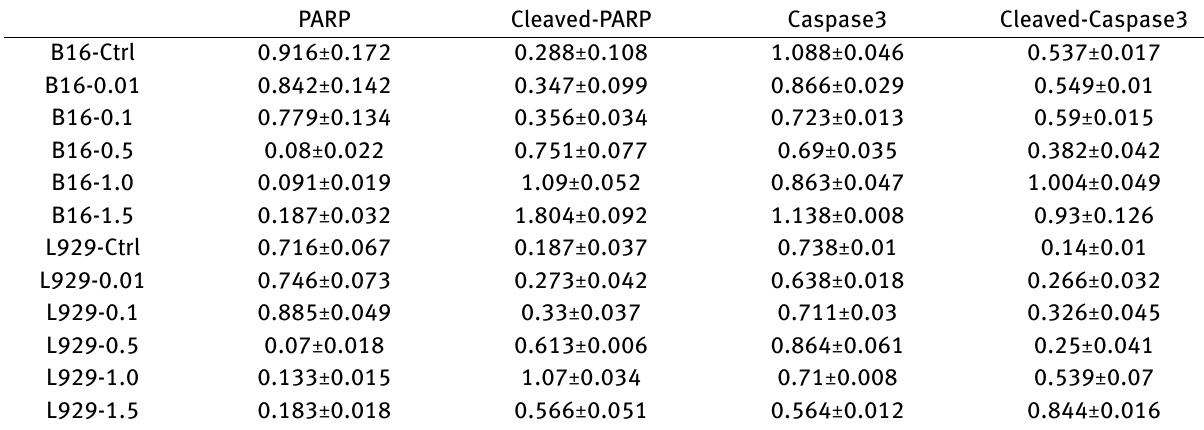
Table S2: Relative protein expression of PARP, Cleaved-PARP, Caspase3, Cleaved-Casepase3 from Western-blot data (Mean ±